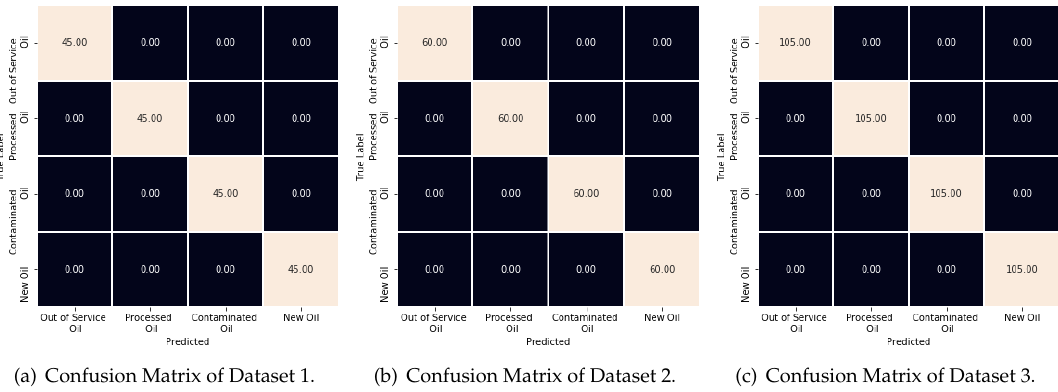
(a) Confusion Matrix of Dataset 1. (b) Confusion Matrix of Dataset 2. (c) Confusion Matrix of Dataset 3. Figure 14. Confusion Matrices of Classification Approach 2: ( a ) Dataset 1; ( b ) Dataset 2; and ( c ) Dataset 3.